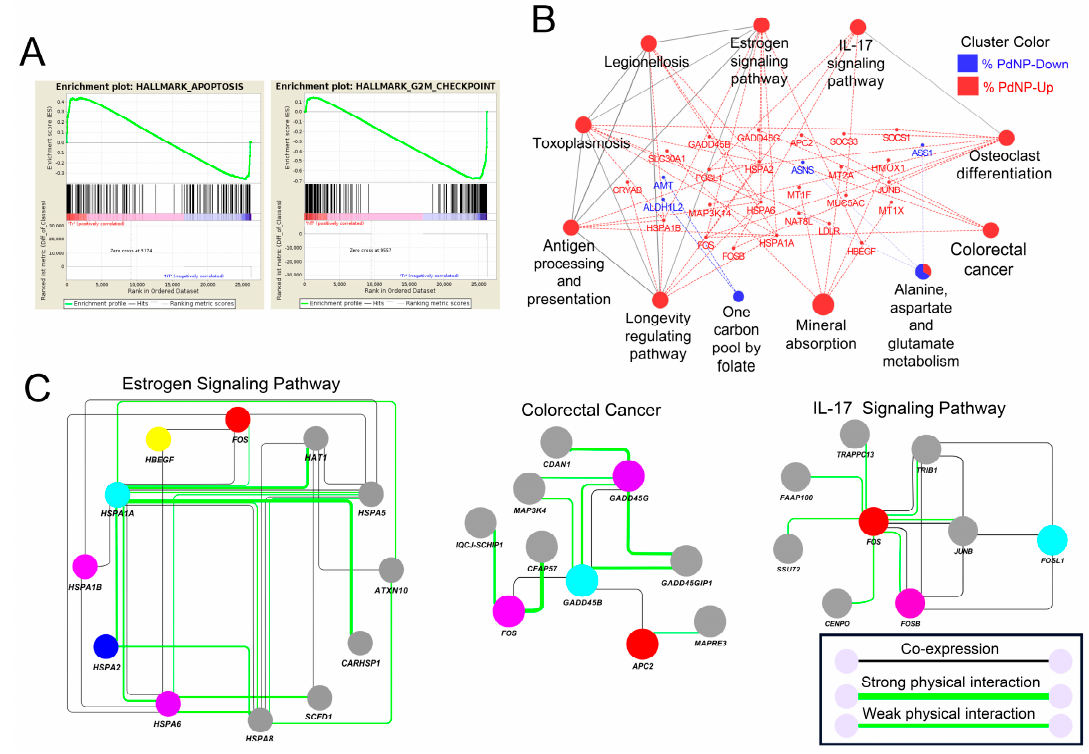
Figure 10. Apoptosis-related pathways were significantly altered by graphene oxide. ( A ) Gene set enrichment analysis (GSEA) showing enriched pathways in the DEGs. Note that genes in the apoptosis and G2 / M checkpoint pathways were significantly changed. ( B ) KEGG analysis showing gene networks and pathways altered by graphene oxide. Red color: Upregulated genes; blue color: downregulated genes. ( C ) Networks showing coexpression and protein-protein interactions in the estrogen, IL-17, and colorectal cancer signaling pathways.